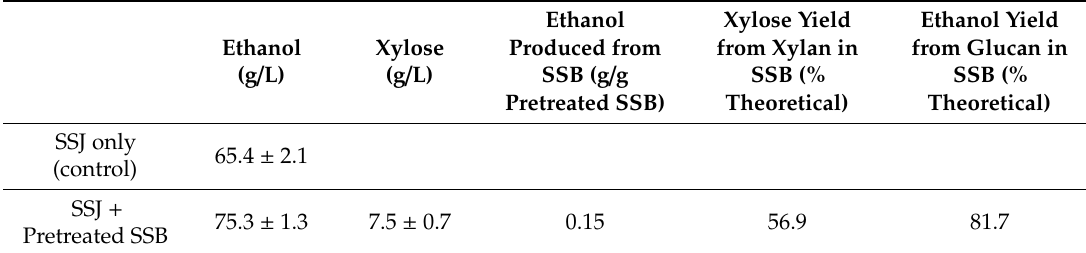
Table 3. Results of ethanol fermentation using Na 2 CO 3 -pretreated SSB in